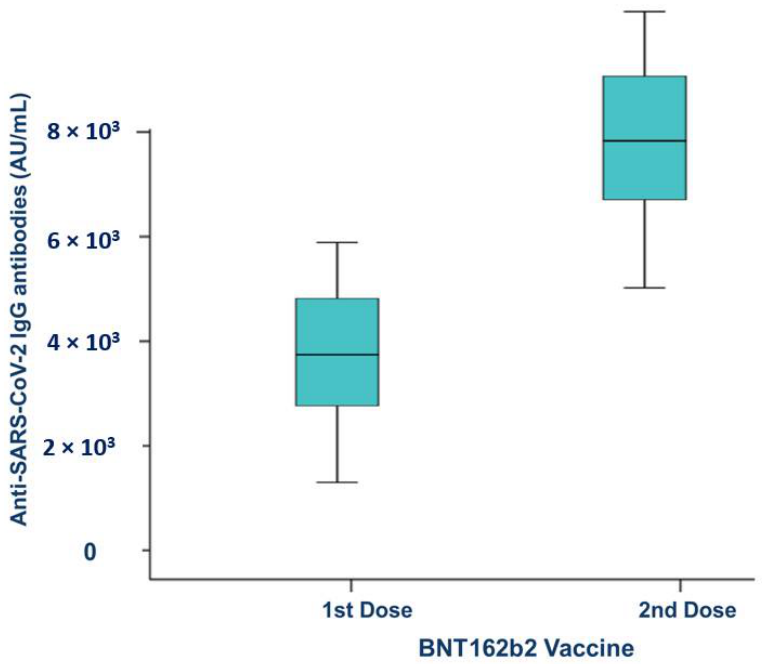
Figure 3. Antibody level generated by the BNT162b2 vaccine.